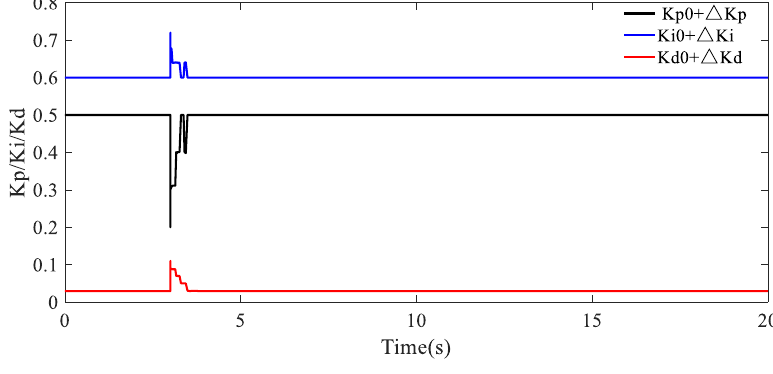
Figure 10. Fuzzy adaptive adjustment of K p , K i and K d .